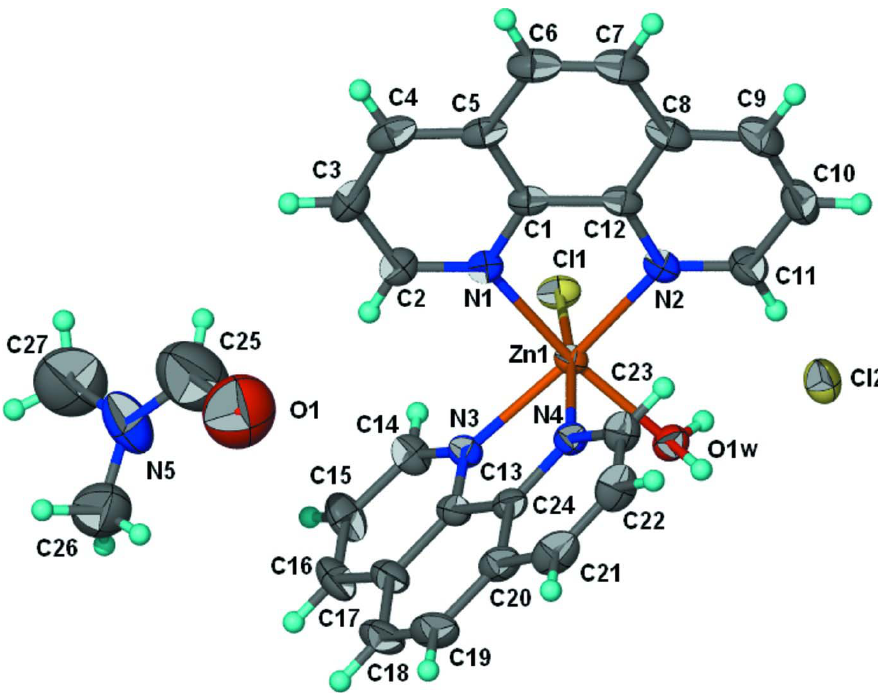
Figure 1 View of the molecular structure of (I); displacement ellipsoids are drawn at the 50% probability level, and H atoms as spheres of arbitrary radius. Only one disorder component of the DMF molecule is